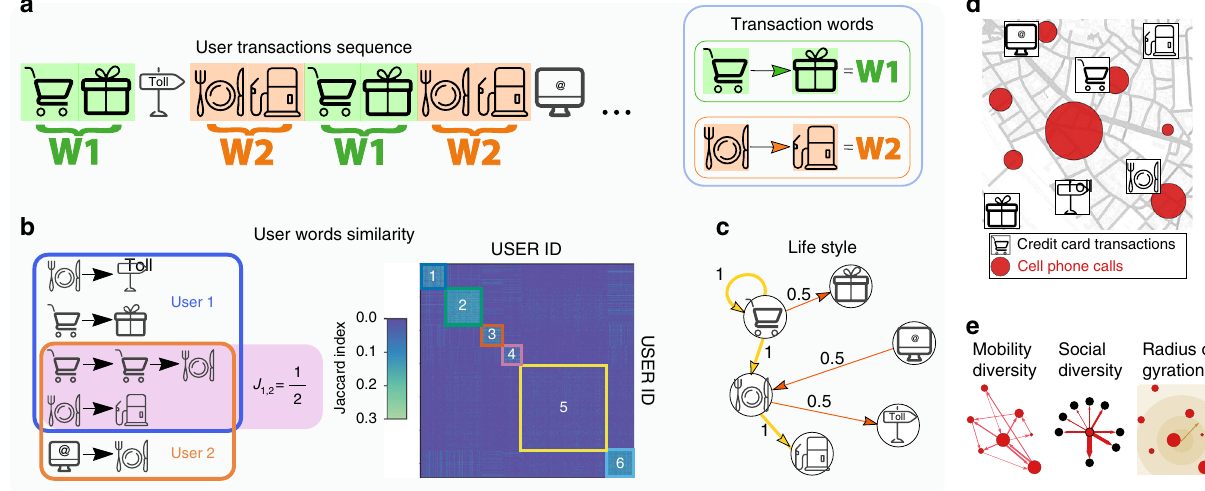
Fig. 2 Methods and metrics. a Schematic representation of the Sequitur ’ s algorithm applied to a sequence of transactions of one user to detect words and identify signi fi cant transaction sequences in the data set. b Calculation of the similarity between two users (left) based on the Jaccard index of their signi fi cant sequences to de fi ne the matrix of users ’ similarity (right). Group of users are detected based on similar sequences of transactions. c Lifestyle representation based on sample users 1 and 2 of b . d Example of traces of CDR and CCR data for the user. e Metrics adopted for the analysis of CDR data. The icons used in this fi gure are work of